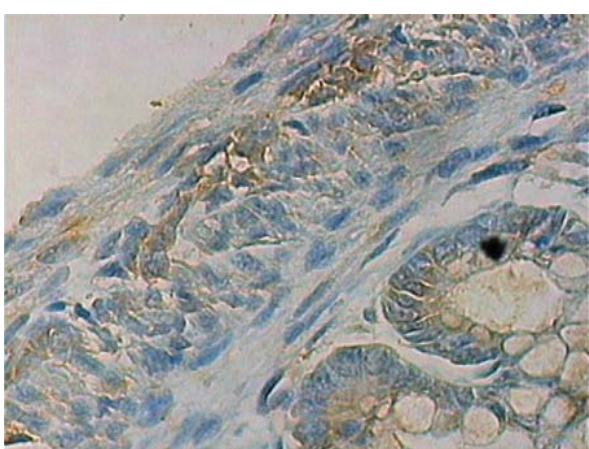
FIGURE 1 – Photomicrography of the terminal intestine of the external control group with S-100 protein staining